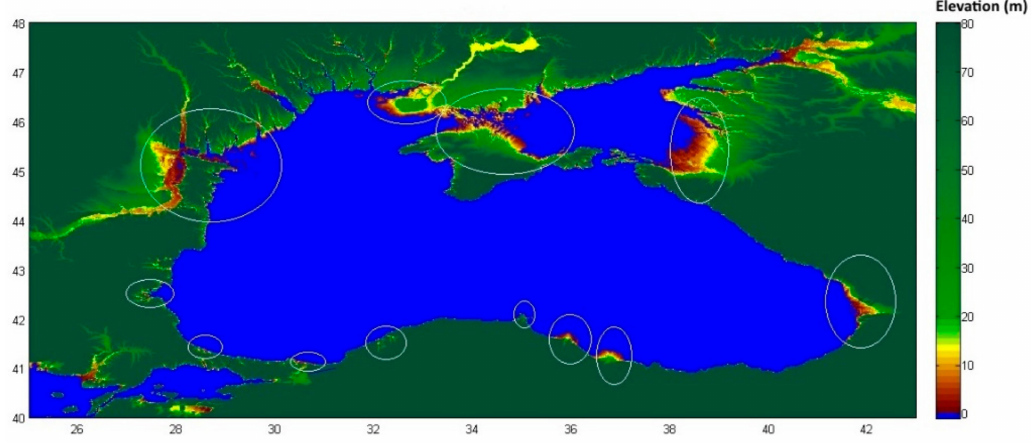
Figure 7. Areas with low slope along the Black Sea